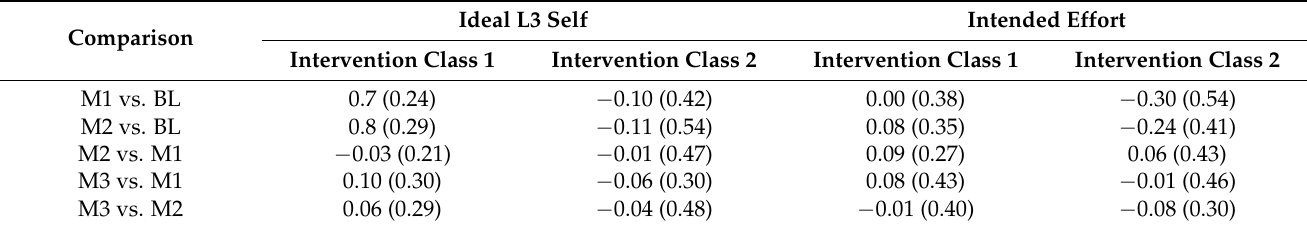
Table 7. Mean and SD for gain scores of ideal L3 self and intended effort according to